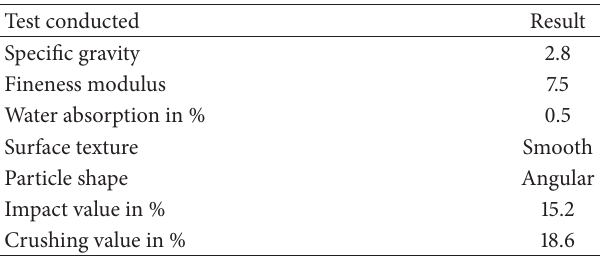
Table 3: Properties of coarse aggregate.